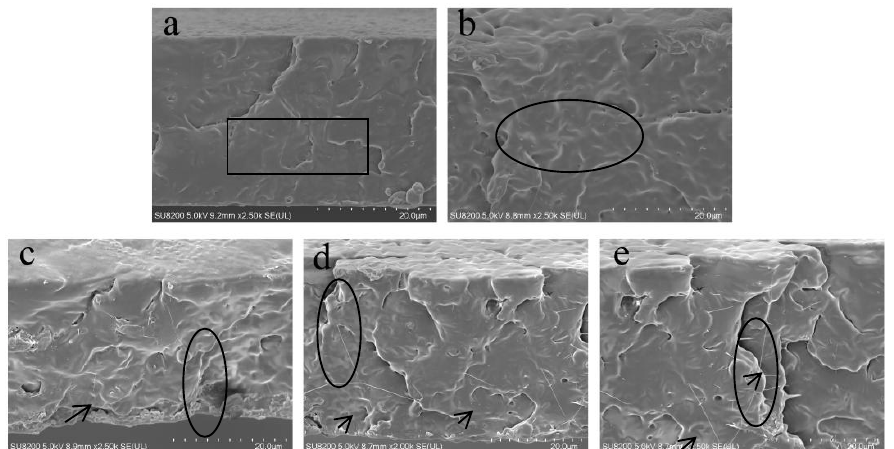
Figure 4. SEM images of the fractured surfaces after tensile testing: ( a ) PLA and the ( b ) PLA/CNFs, ( c ) PLA/5-LCNFs, ( d ) PLA/9-LCNFs, and ( e ) PLA/14-LCNFs composites.